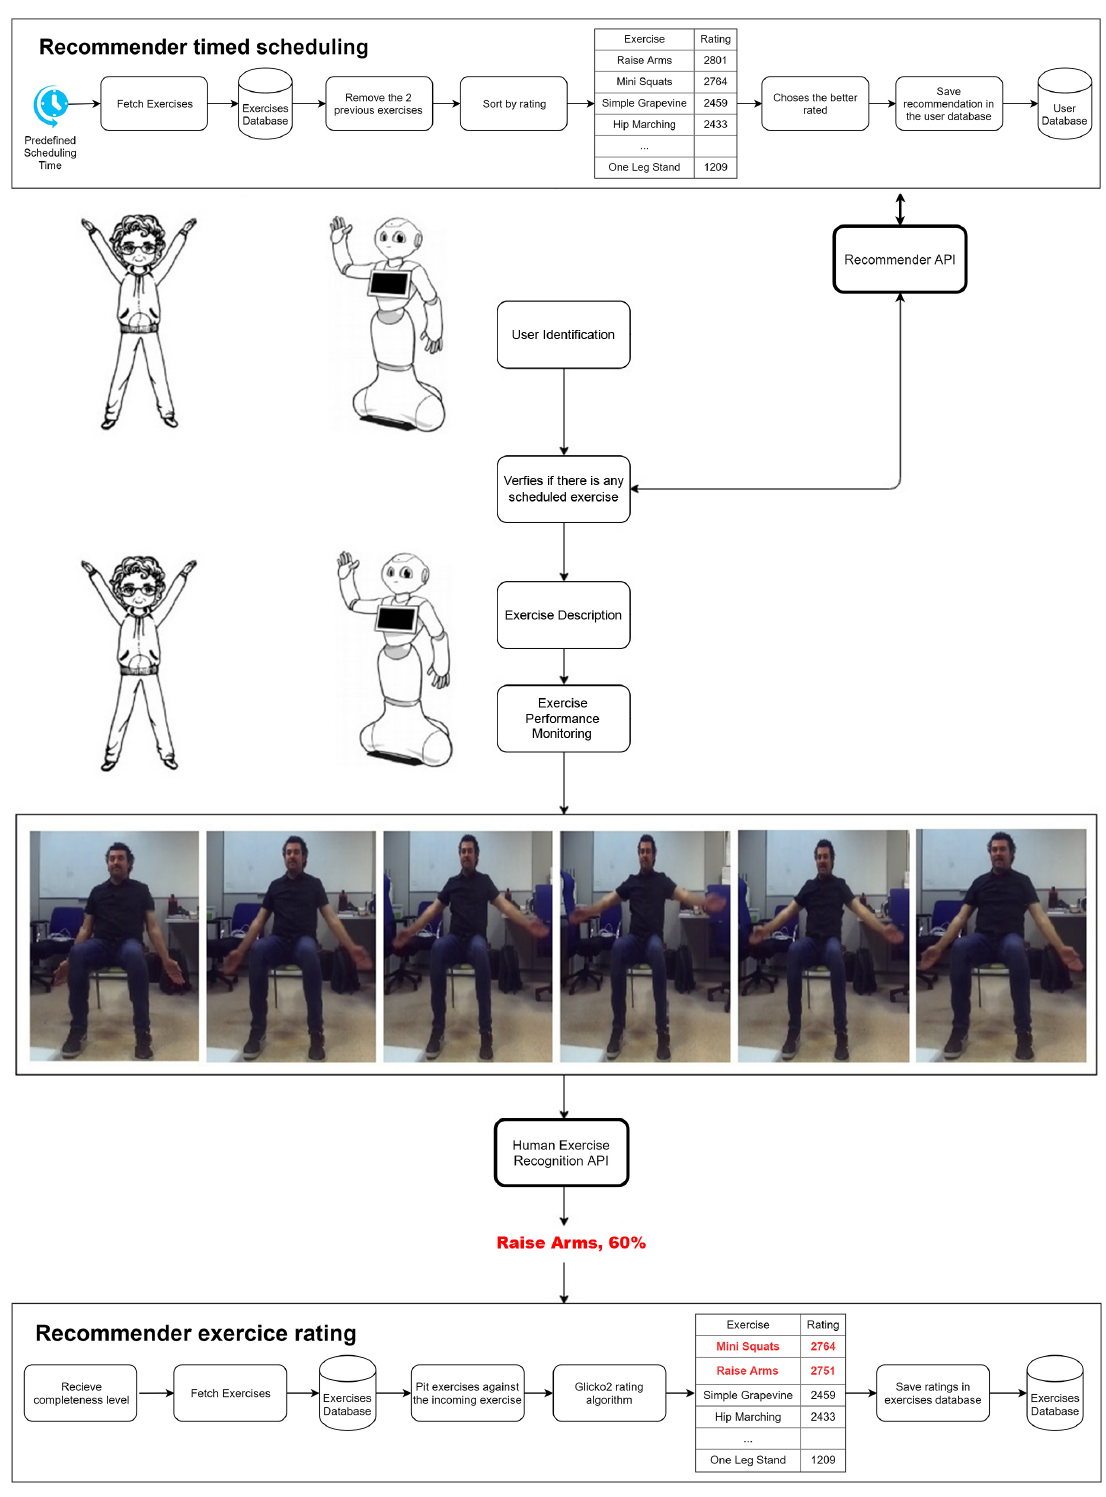
Figure 7. A real execution of PHAROS